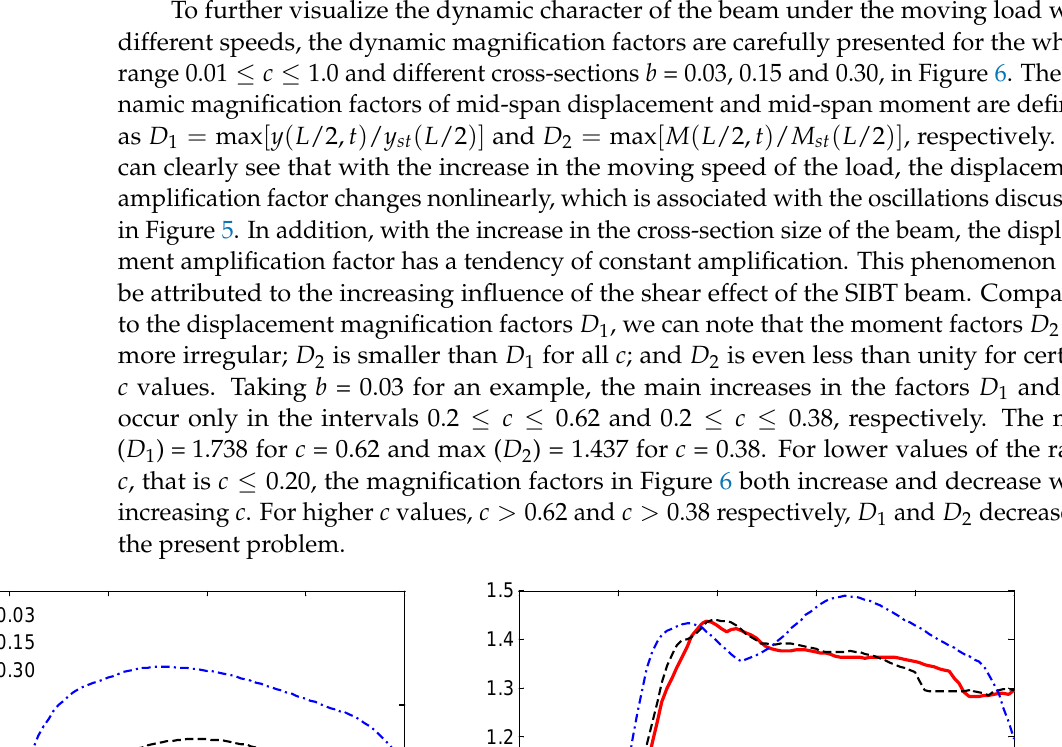
1.0 c   and different cross-sections b = 0.03, 0.15 and 0.30, in Figure 6. The